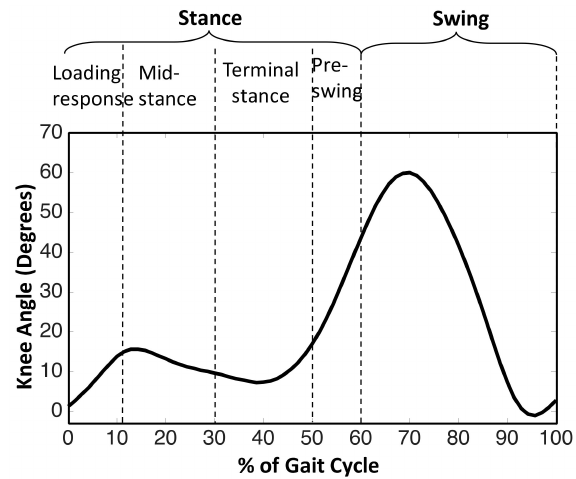
Figure 3. Typical gait cycle of a healthy person [33] and its classification